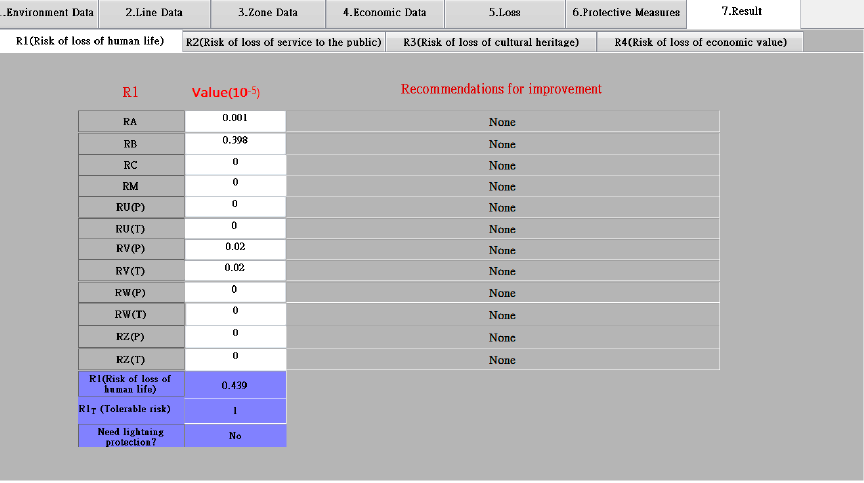
Figure 8. The R1 after using protection measures.